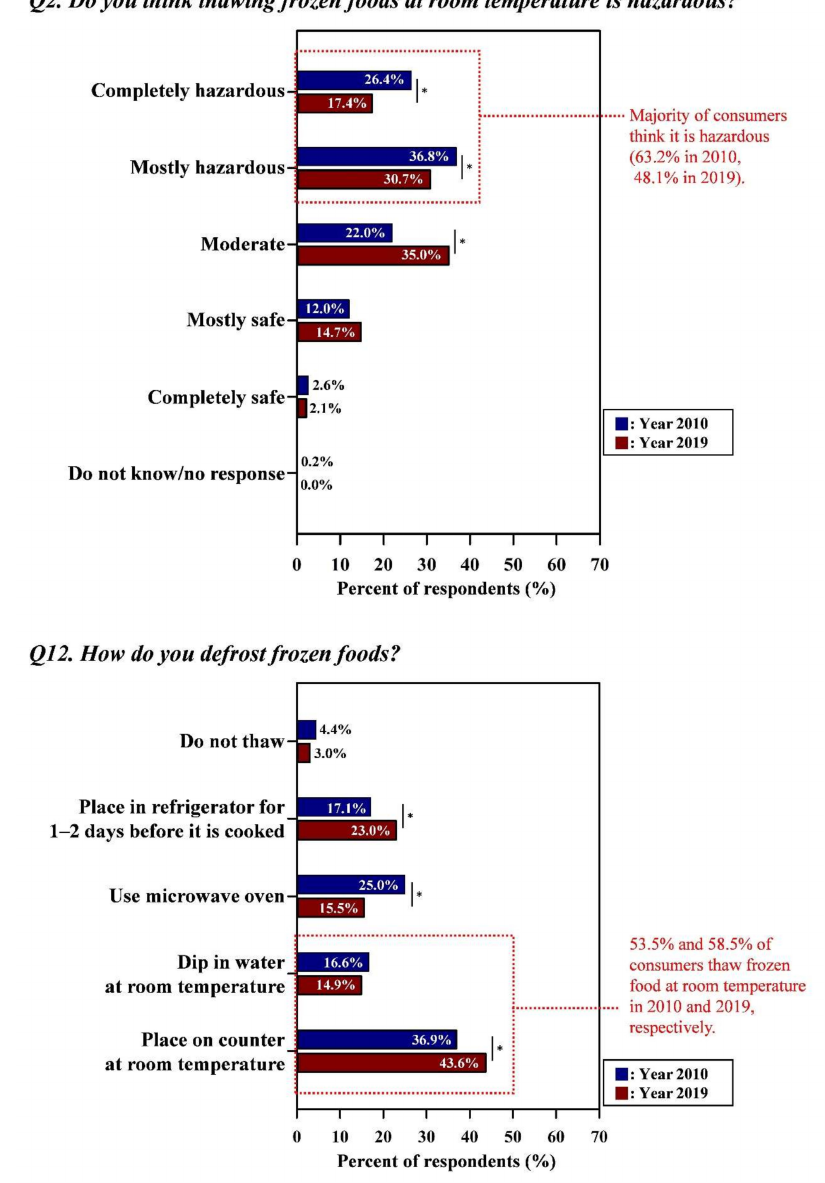
Figure 2. The gap between the consumers’ perceptions and behaviors regarding frozen foods. Asterisk (*) indicated between graphs means the significant di ff erences of responses (the Kruskal–Wallis test; p < 0.05) in each answer option from Year 2010 and Year 2019. Red letters indicated the improper risk perceptions (i.e., the response in opposition to conventional food safety guidelines) and high-risk behaviors of consumers. All data regarding the percentage of the combined answer options (e.g., Always + Frequently) are provided in Table